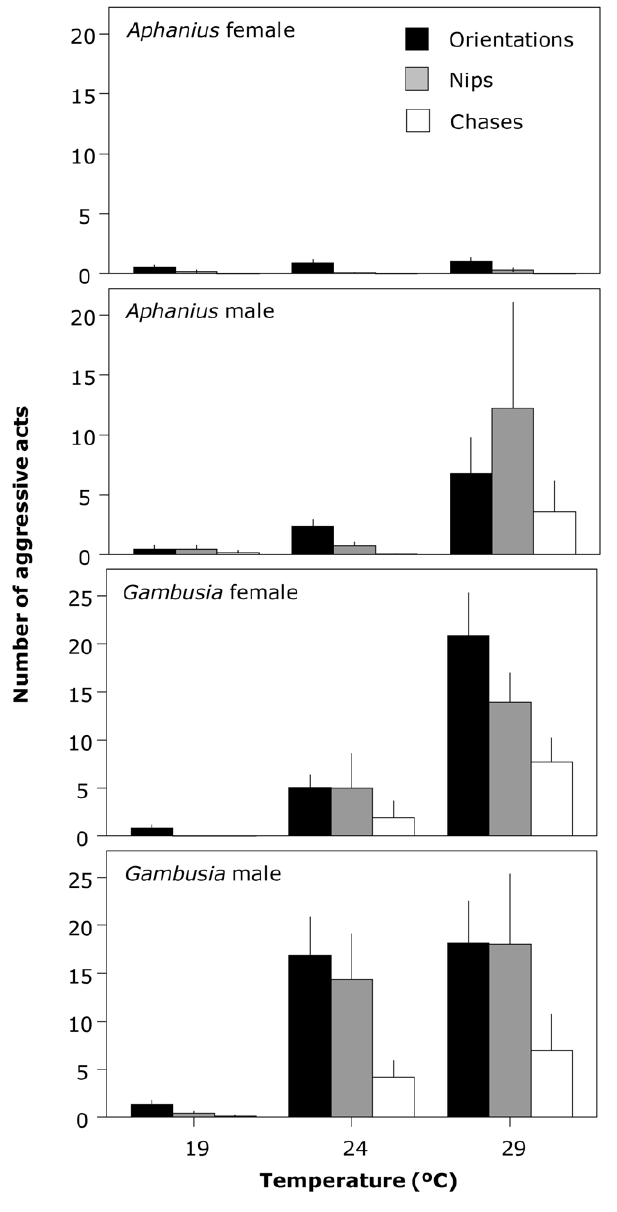
Figure 2. Aggressive acts (orientations, nips and chases) performed by Gambusiaholbrooki towards Aphaniusiberus and vice versa under the different temperature treatments and species combinations. Means and SE (error bar) are shown. Note the different scales on the y -axis for each species.